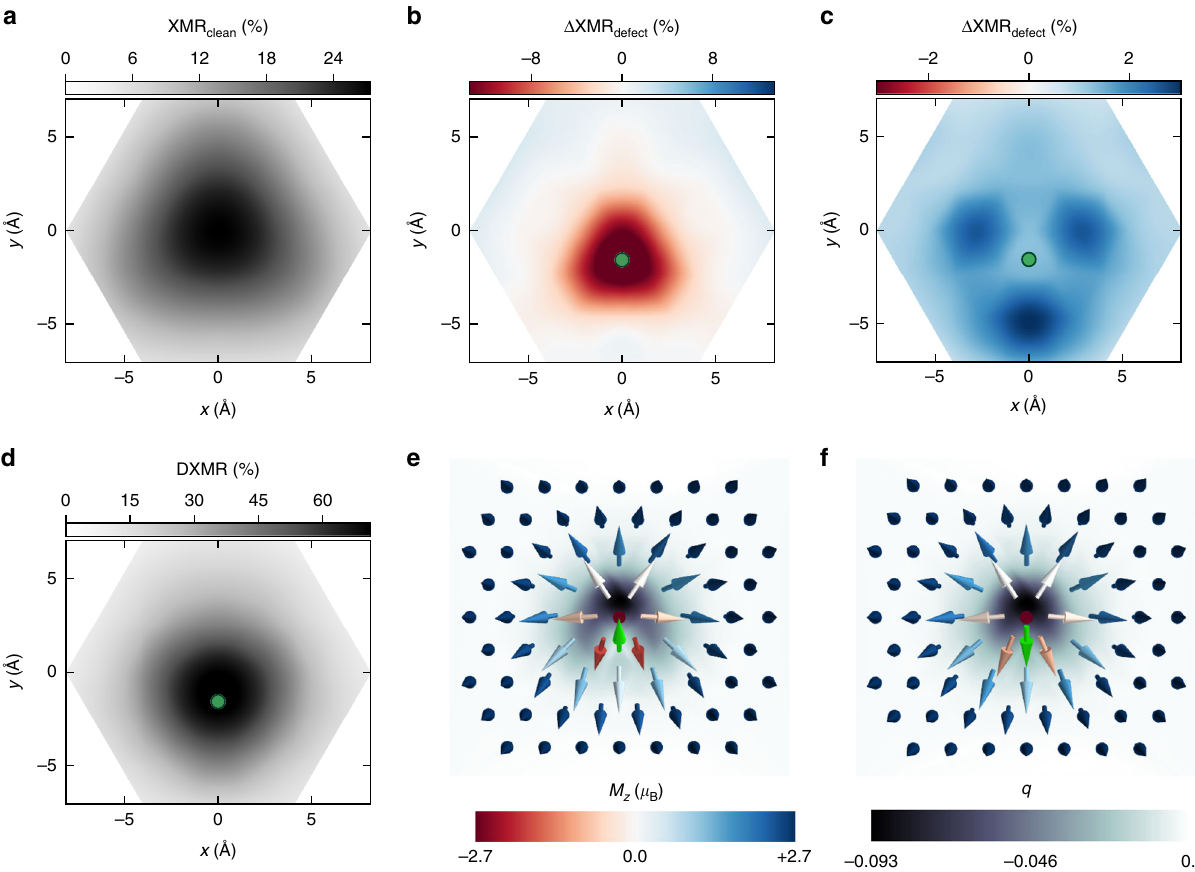
Fig. 5 Impact of single-atomic defects on XMR-signals of skyrmions. a Defect-free XMR signal compared to d DXMR signal induced by a Cr impurity. Difference between XMR defect and XMR clean plotted for b Cr and c Ni impurities close to the core of skyrmion. The green circle indicates the position of the impurity. The corresponding skyrmion magnetic textures and the topological charge monitoring the non-collinearity are shown in ( e ) for Cr and ( f ) for Ni, where the green arrow represents the impurity magnetic moment while the rest of arrows are those of the Fe atoms. The red-blue color bar represents the magnitude of the out-of-plane magnetization ( M z ) of each Fe atom while the grayscale color bar is used for the topological charge computed for triangles de fi ned by sets of three nearest neighboring atoms. An interpolation is then performed between the discrete values of the